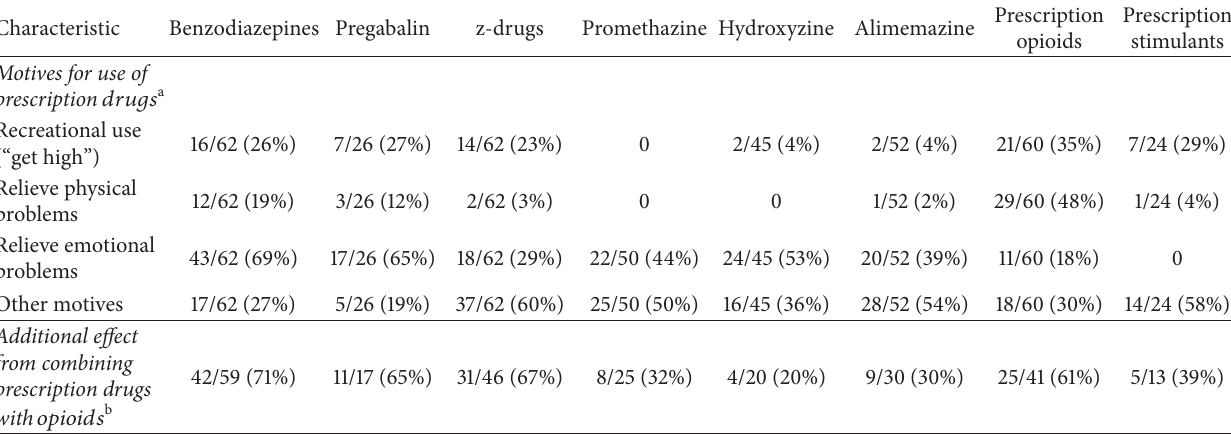
Table5:Motivationforuseofprescriptiondrugsingeneralandincombinationwithstrongopioids(heroin,methadone,andbuprenorphine). Not mutually exclusive. Presented as n (% of persons reporting lifetime use/combined